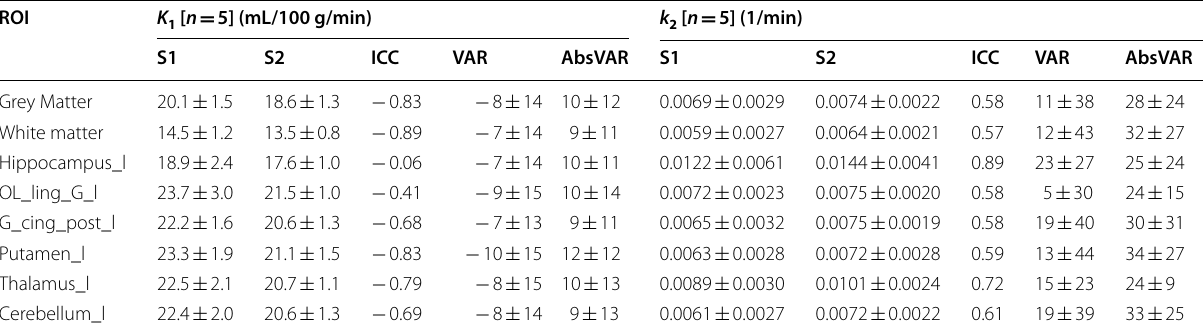
Table 3 Repeatability metrics for [ 13 N]ammonia one-tissue compartment (reversible) model parameters for grey matter and selected regions of interest (ROIs)